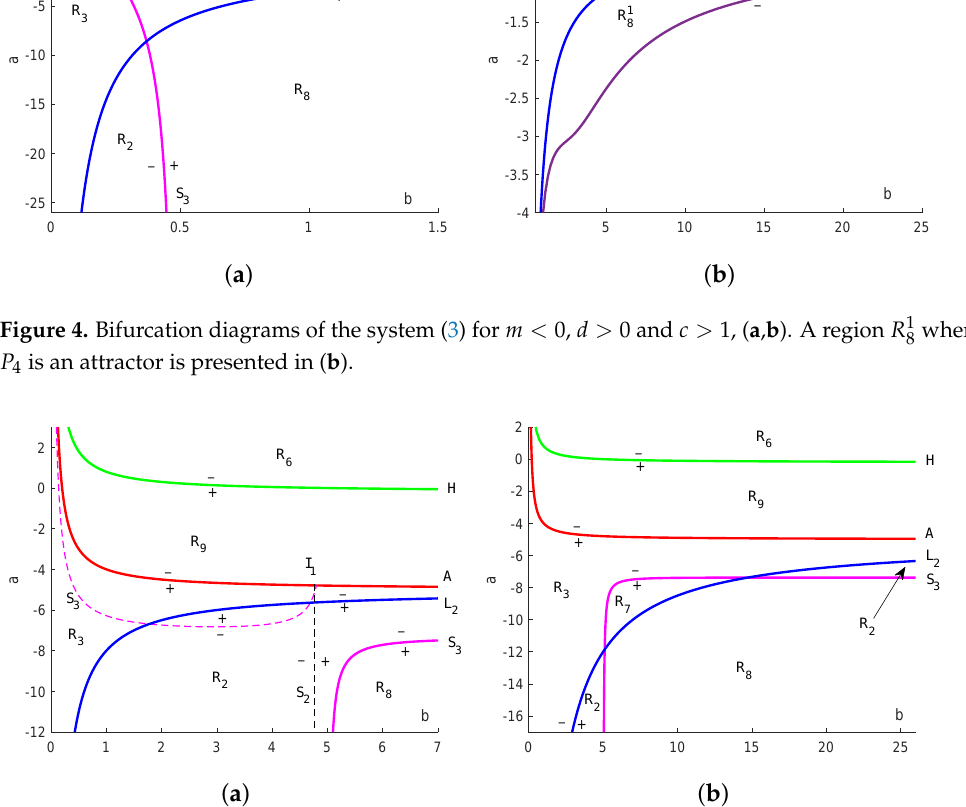
Figure 5. Bifurcation diagrams of the system (3) for 0 < c < 1, d > 0 and ( a ) − c 0 d < m < 0, respectively, ( b ) m < − c 0 d <